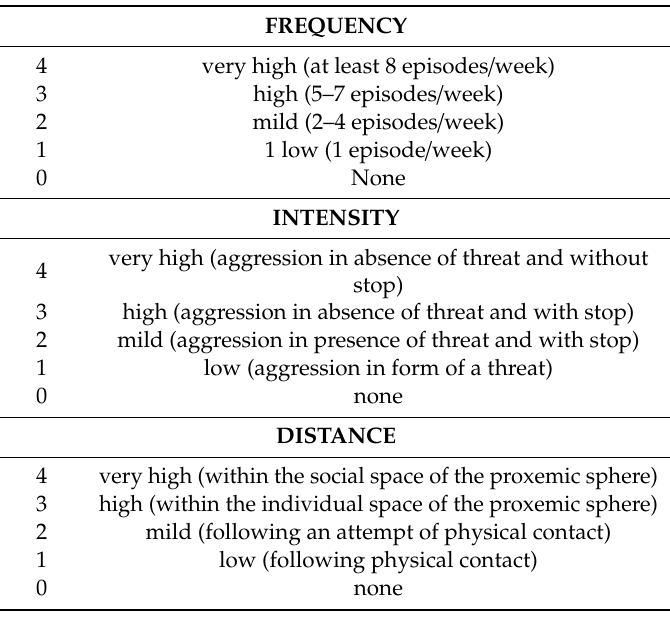
Table 1. Evaluation of dog aggression on a five-point frequency scale